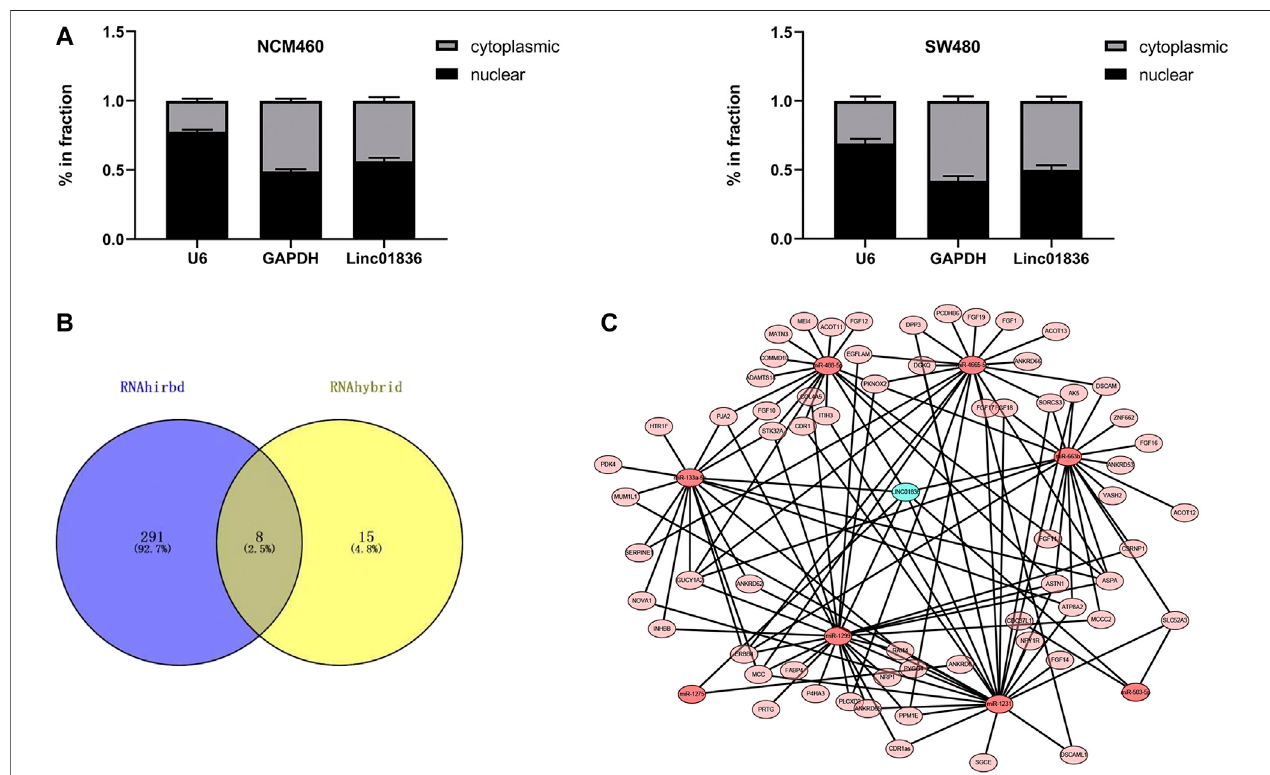
FIGURE 5| Exploration of the downstream regulatoryceRNA network of Linc01836 in CRC. (A) Detection ofLinc01836 localization in NCM 460 and SW480 cells by nuclear and cytoplasmic RNA separation assay. (B) Schematic illustration exhibiting the overlap between the target miRNAs predicted by RNAhirbd and RNAhybrid database. (C) Prediction of lncRNAs – miRNAs – mRNAs network map of